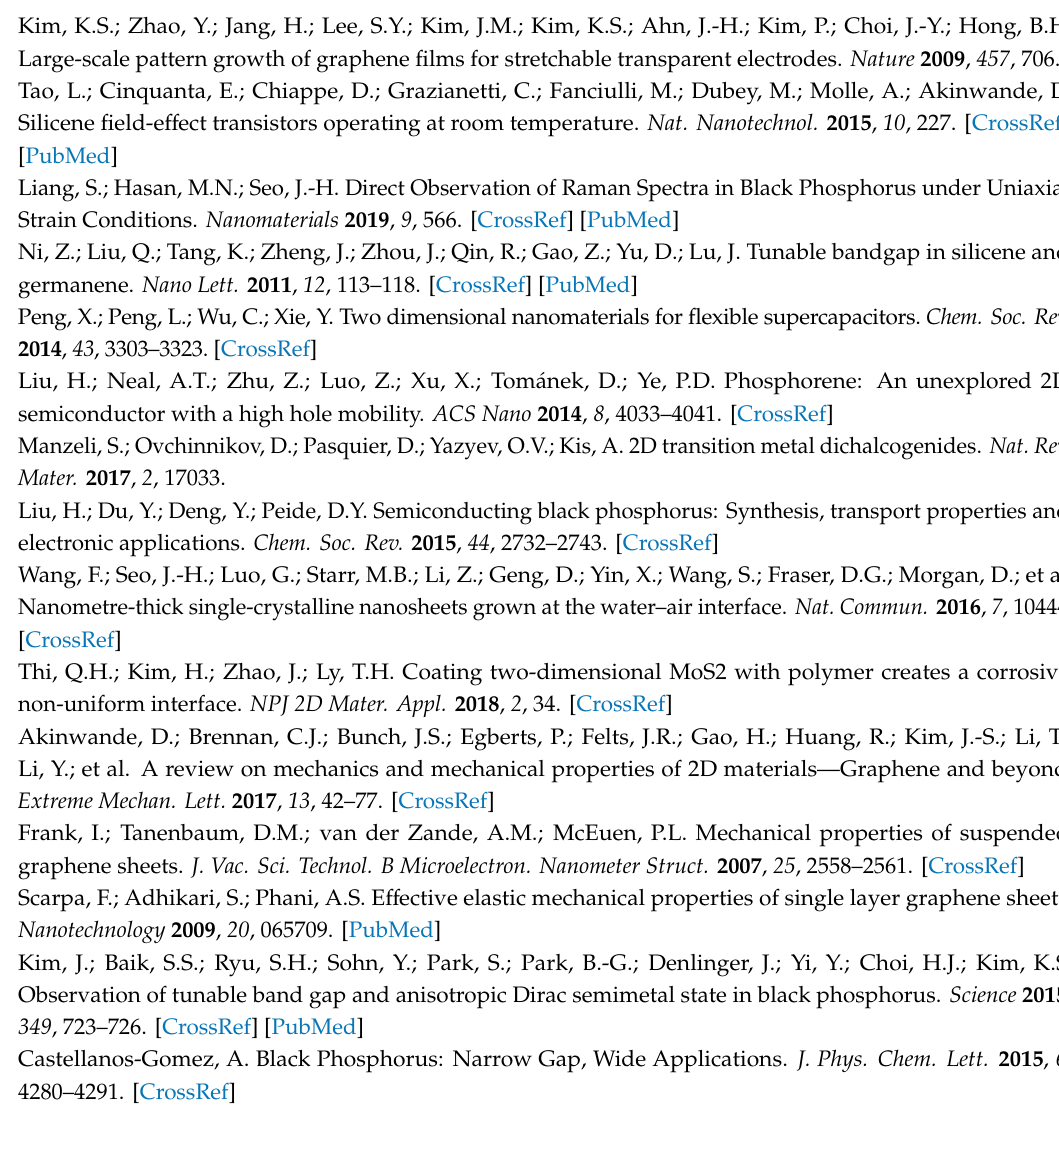
Figure S1: Microscopic images of MoS 2 taken from YSZ substrate under di ff erent temperature from 700 ◦ C to 800 ◦ C. Figure S2: AFM image of few-layered MoS 2 crystal on flexible YSZ substrate. Figure S3: Raman shift rate of E1 2g and A 1 g mode peaks as a function of bending